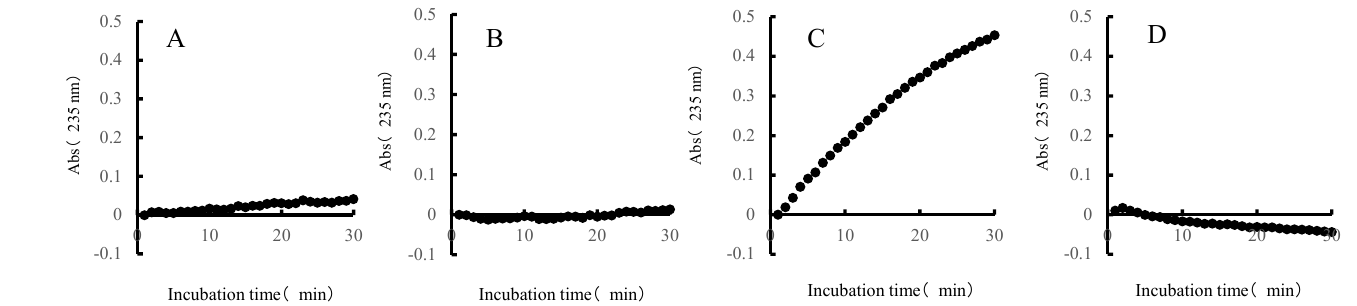
8 of 12 Figure 5. Reaction time course (235 nm) of ulvan and cell-clashed solutions (( A ), Alteromonas sp. ul20-2; ( B ), Vibrio sp. 10N; ( C ), Echinicola sp. 20G; ( D ), negative control). 3.4. Identification of Genes Related to Ulvan Degradation in Echinicola sp. 20G From the full genome information of Echinicola sp. 20G (annotated using RAST), pol- ysaccharide utilization loci (PUL) related to ulvan lyase were observed in two different